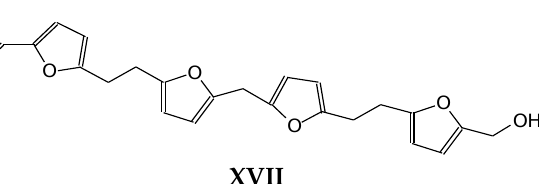
Scheme 9. Example of reaction of simpler humins structure capable of reacting with itself to form more complex humins networks.